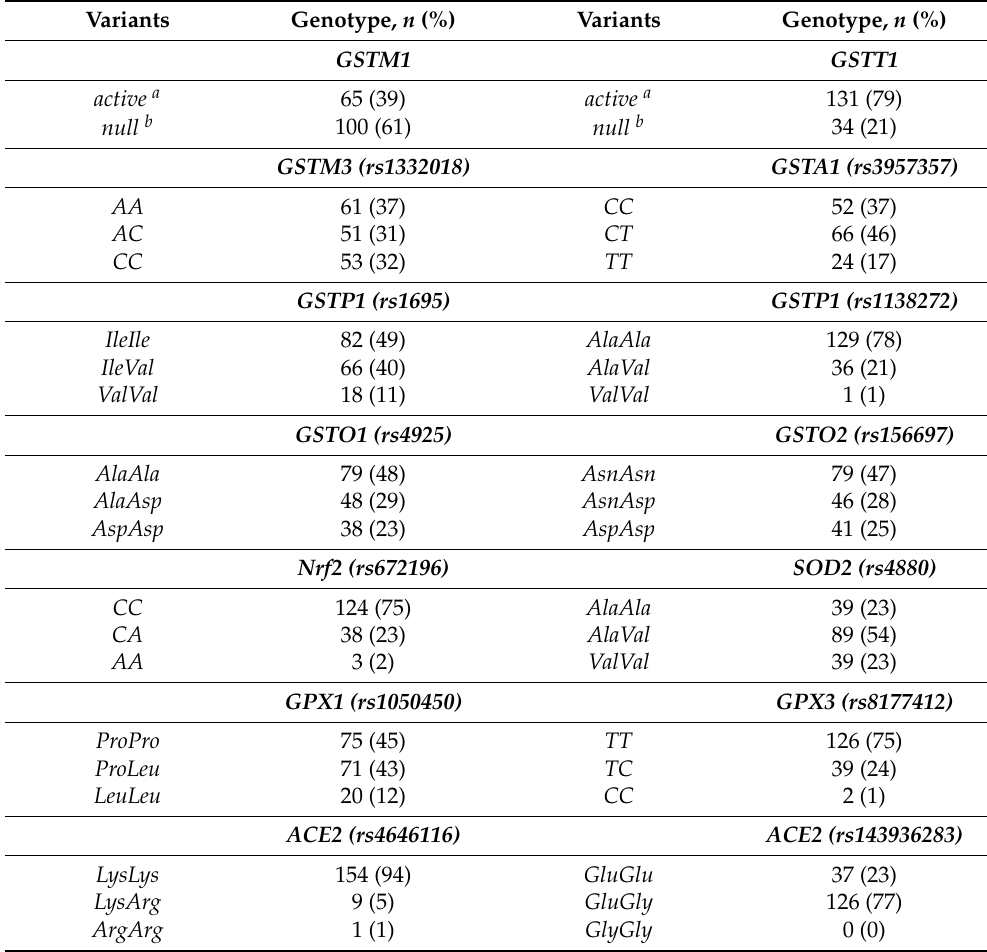
Table 4. Distribution of analyzed genotypes in COVID-19